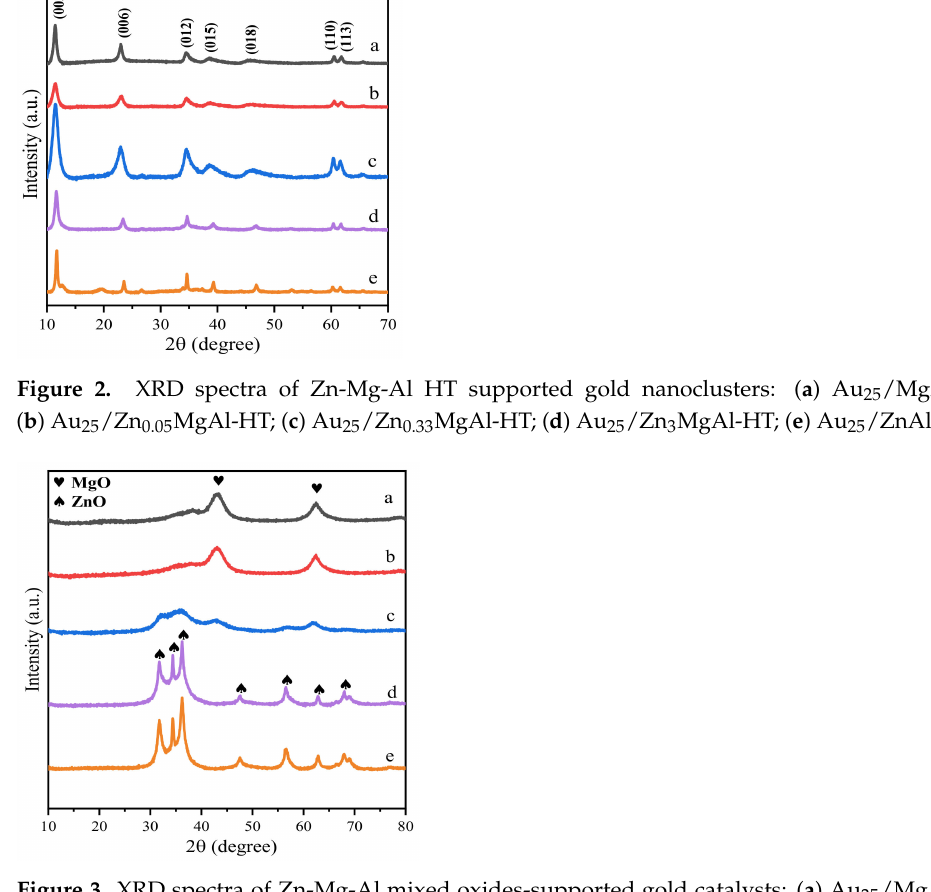
Figure 3. XRD spectra of Zn-Mg-Al mixed oxides-supported gold catalysts: ( a ) Au 25 /MgAl-400; ( b ) Au 25 /Zn 0.05 MgAl-400; ( c ) Au 25 /Zn 0.33 MgAl-400; ( d ) Au 25 /Zn 3 MgAl-400; ( e ) Au 25